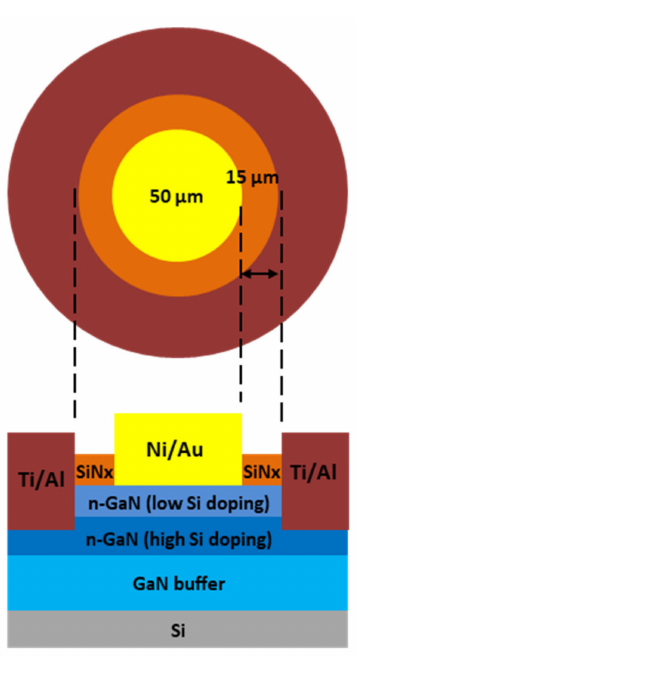
Figure 7. Cross-section of the Schottky diodes fabricated on